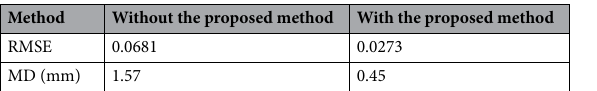
Method Without the proposed method With the proposed